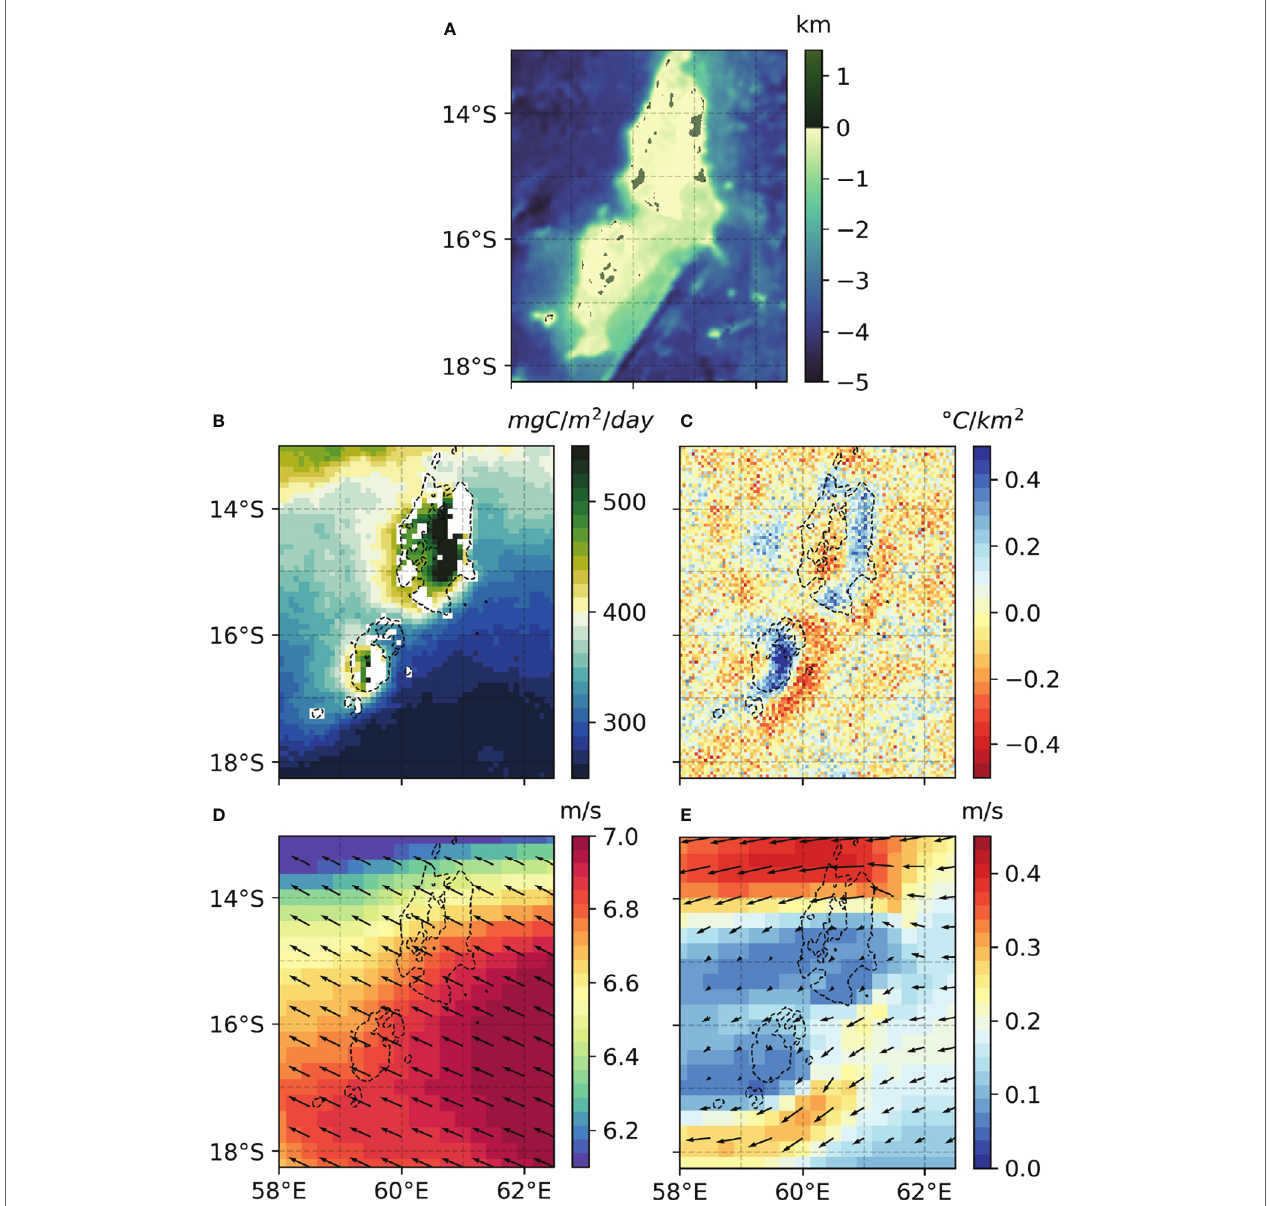
FIGURE 12 | Saint Brandon Islands (Mauritius), (A) Topography, (B) NPP, (C) SST Laplacian, (D) Wind Speed, (E) Currents, annual average 2013. Black dashed line represents the 100 m depth